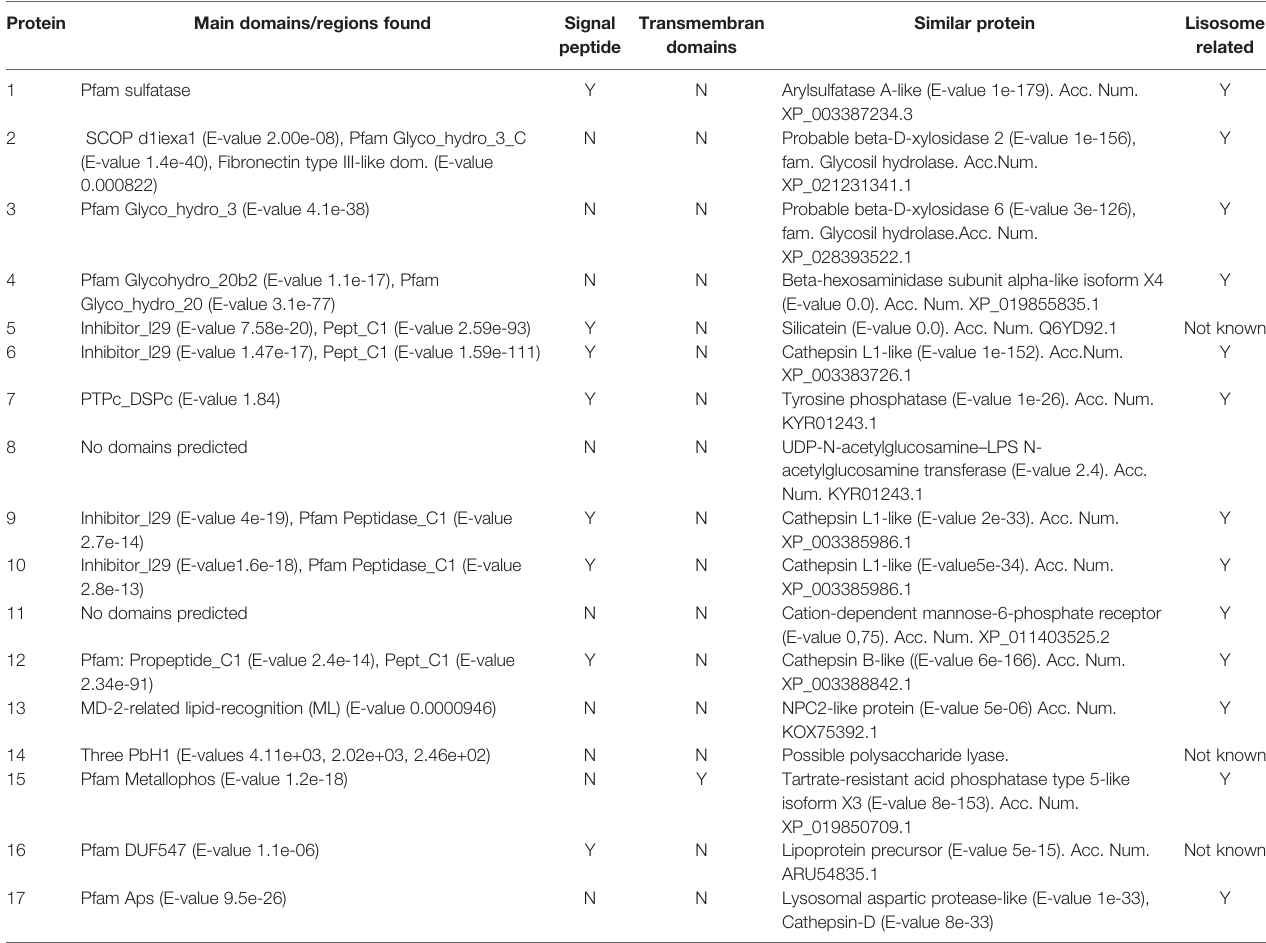
TABLE 1B | Main conserved domains. Protein Main domains/regions